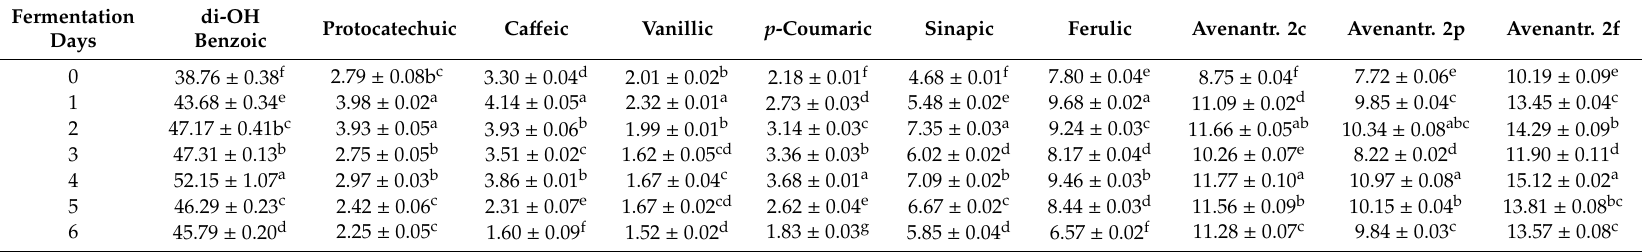
Table 3. Phenolic compounds’ analysis as per fermented oat bran samples / fermentation